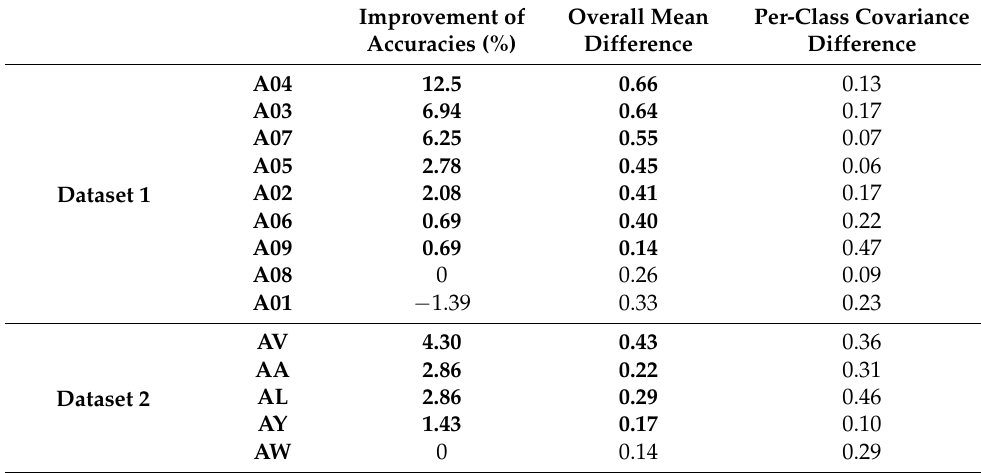
Table 5. The accuracy improvement after MA and the overall mean difference and per-class covari- ance difference in the two domains before MA.